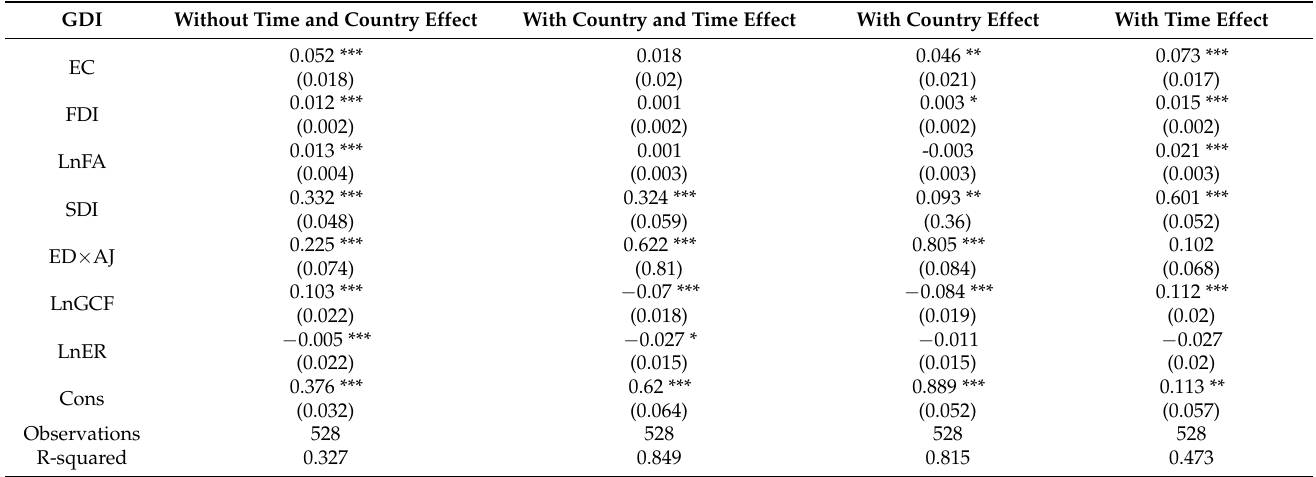
Table 1. Results of Simple Linear Regression 2000–2020 for 24 Asian Economies. Dependent variable: Gender Development Index (United Nations